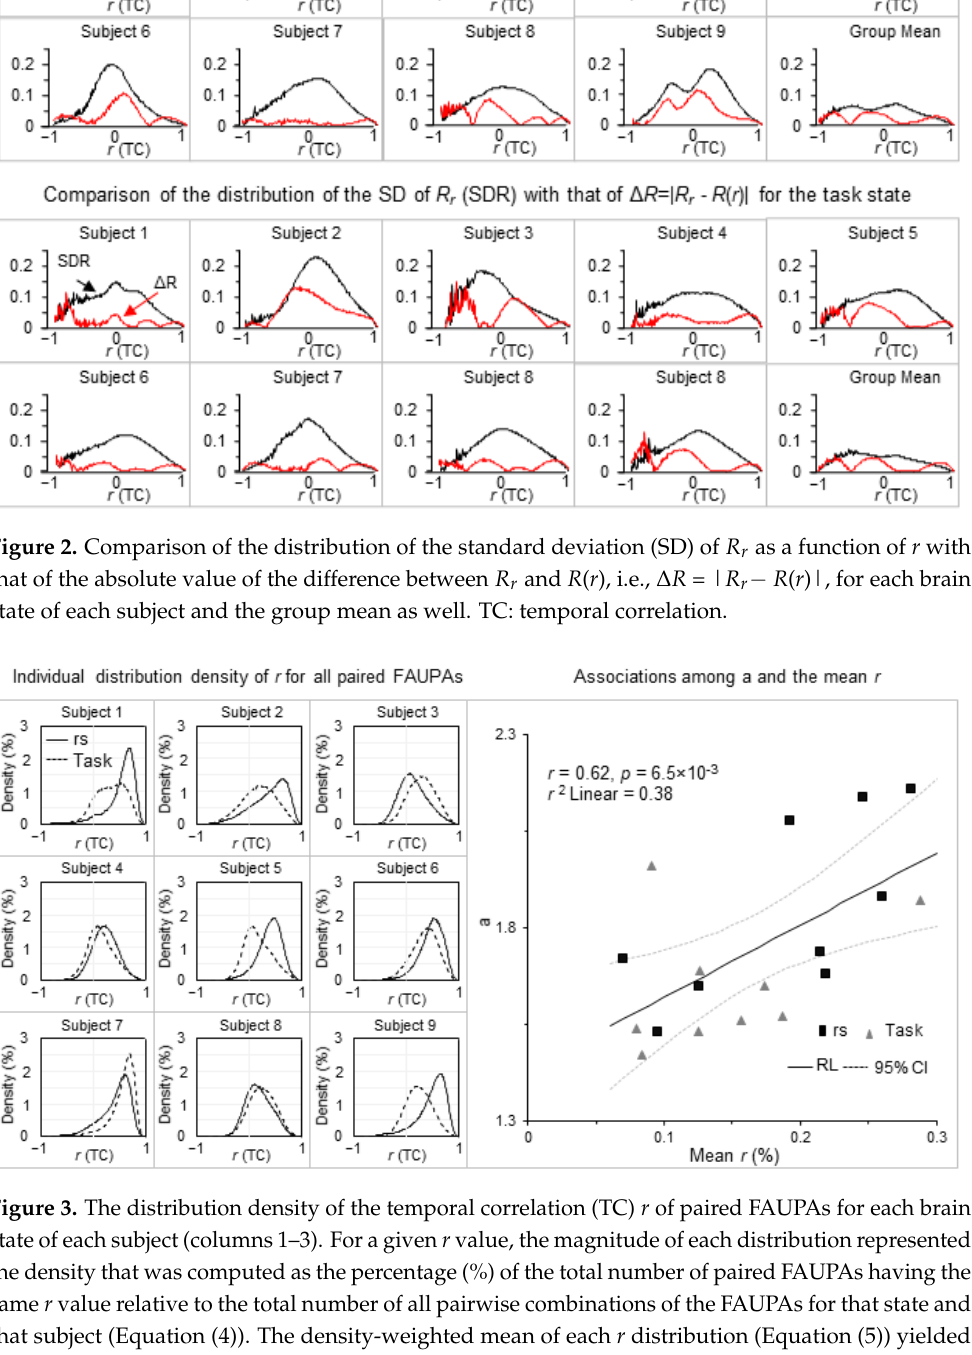
the mean co-activity among all the FAUPAs. Note that, for each subject, the difference between the difference between the two mean r values of the two brain states (Table 1) clearly reflected the dif-